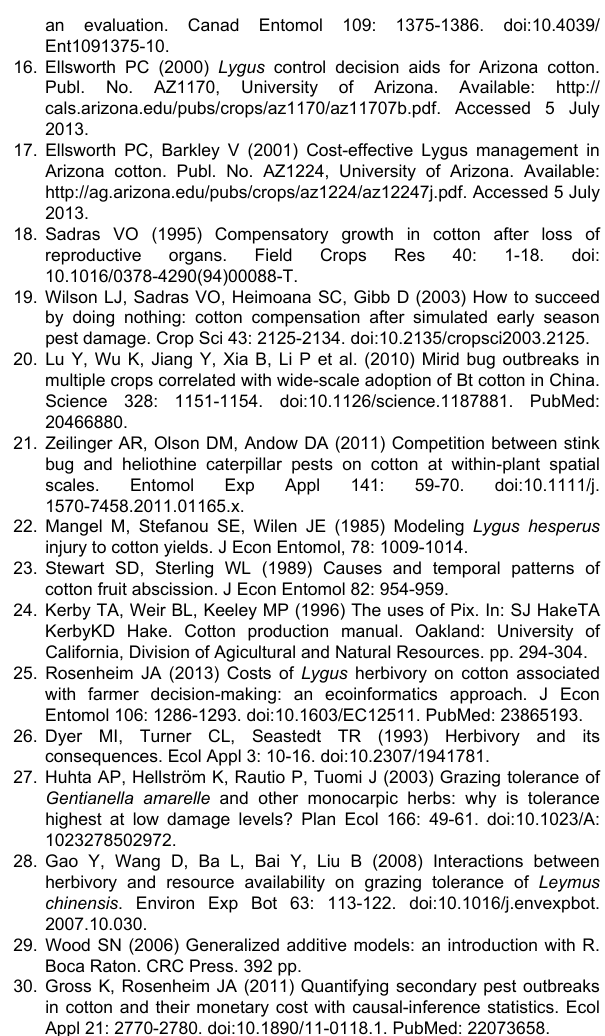
Table S8. Generalized additive model of factors associated with yield of cotton, Gossypium spp., including both L. hesperus densities and the monthly mean temperatures and rainfall beginning October of the year preceding the spring planting of the focal cotton